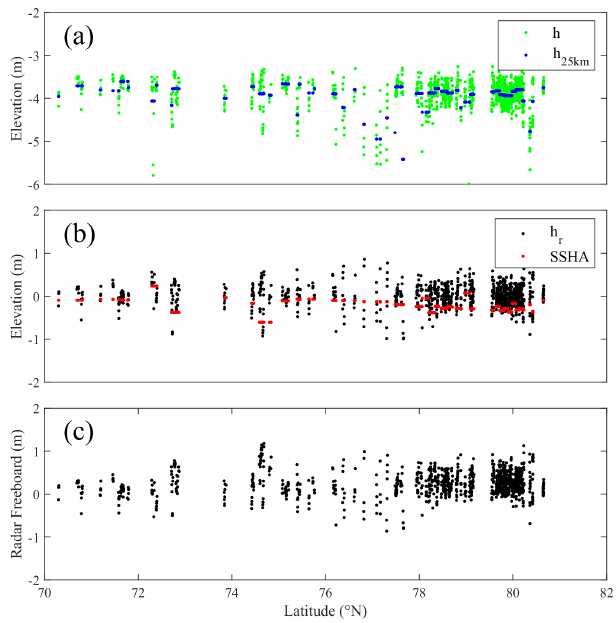
Figure 3. A sample of the HY-2B elevation profile obtained for track number 14418 on 4 April 2020. The green points in panel (a) are the relative elevation ( h ) values; the blue points in panel (a) are the h 25km values, defined as the 25km running mean of h ; the black points in panel (b) are the modified relative elevation ( h r ) val- ues; the red points in panel (b) are the sea surface height anomaly (SSHA) values; and the black points in panel (c) are the radar free- board